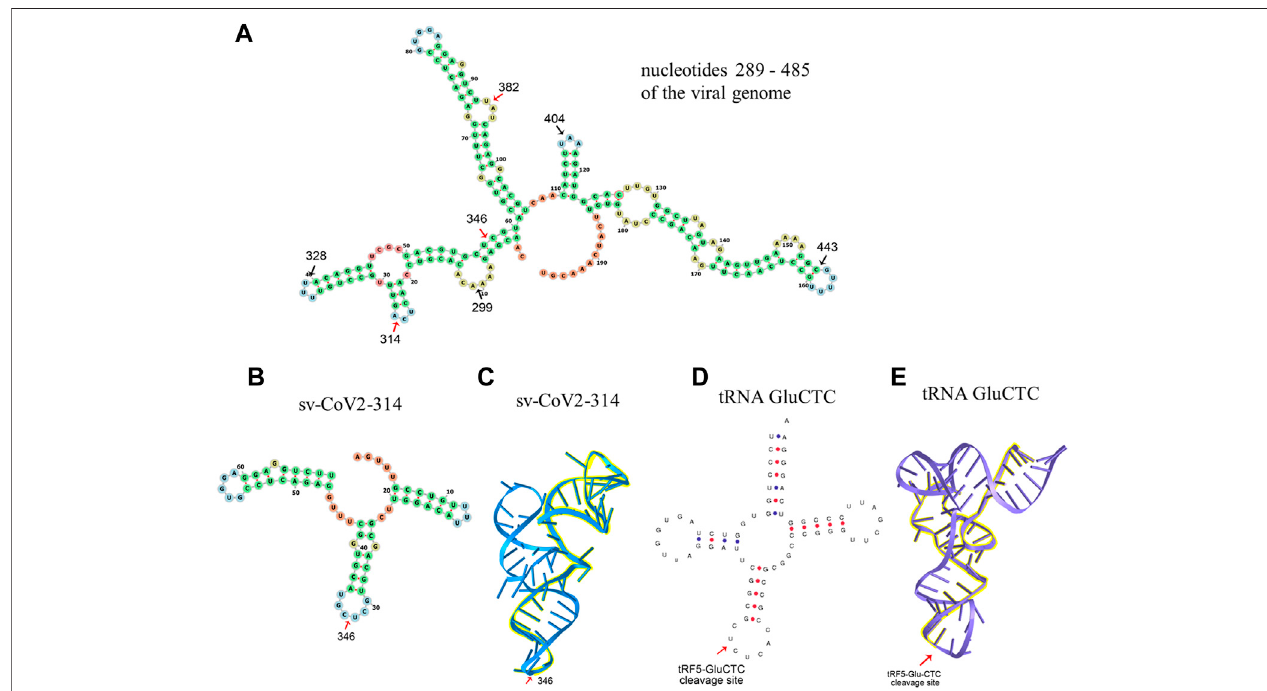
FIGURE 8 | Structure prediction of viral small RNA. (A) The secondary structure of viral nucleotides 289 – 485. The secondary (B) and tertiary (C) structure of sv- CoV2-314. The secondary (D) and tertiary (E) structure of a tRNA example GluCTC. Arrows indicated cleavage